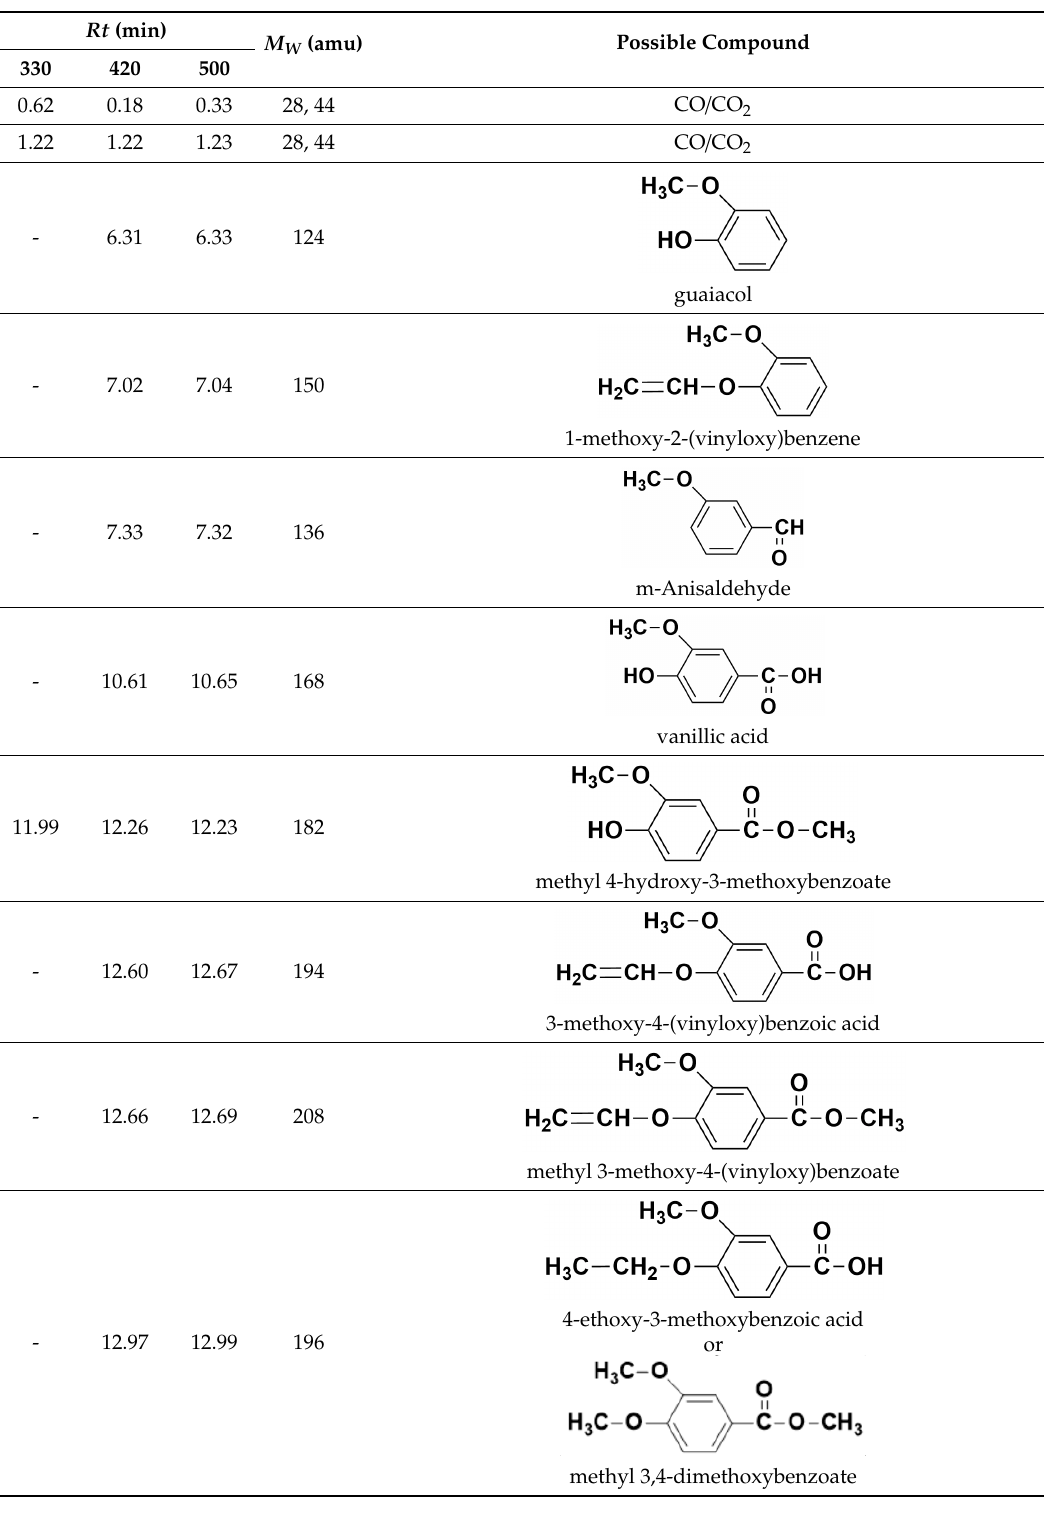
Table 2. Identified thermal degradation products of PEV after pyrolysis at di ff erent temperatures. The retention times of the larger peaks are denoted in